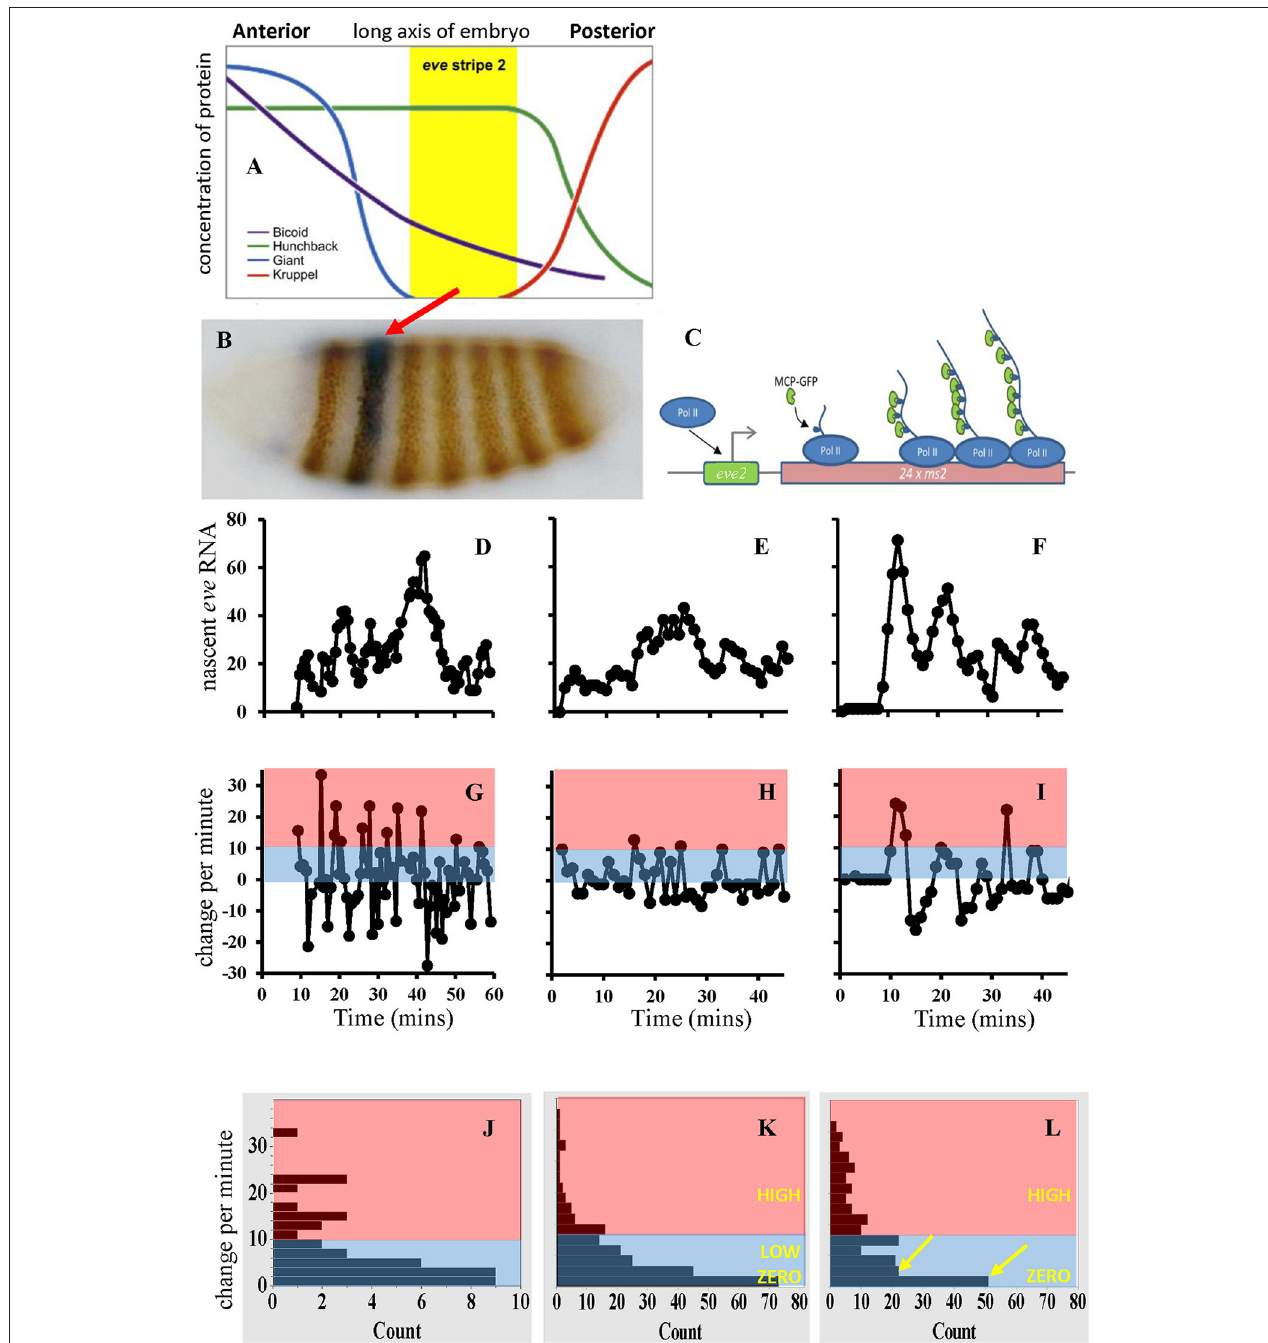
FIGURE 1 | (A) Spatial expression of several Drosophila segmentation genes. (B) eve gene expression stripes on an interphase 14 embryo. Red arrow, eve stripe 2. (C) Schematic of the MCP/MS2 system. “ eve2 ” represents the CRE controlling transcriptional initiation (right-angle arrow); see Figure 2A for an expanded view and model of this eve MSE. PolII transcribes multiple MS2 loops in addition to the target gene. MS2 loops in the nascent RNA bind MCP tagged with green fluorescent protein (GFP). (D) Experimental time series from a nucleus in the center of eve stripe 2, from Bothma et al. [54]. (E) A stochastic simulation for OFF-LOW-HIGH eve2 transcription (model in Figures 2A,B ). (F) A simulation of simple OFF-ON transcription. Experimental time series exhibit a 10min initial lag, simulation dynamics start at time 0; time axes same as (G–I) , vertical scale (number of transcript molecules) shared (D–F) . (G–I) Corresponding change per minute for the data (G) , and for the OFF-LOW-HIGH (H) , and OFF-ON (I) simulations. Pink, minutes with high initiation; blue, minutes with low to zero initiation. (J–L) Distributions of change-per-minute for data ( J , from G ), OFF-LOW-HIGH ( K , 10 pooled simulations) and OFF-ON ( L , also 10 simulations; yellow arrows indicate dichotomy in low to zero rates not seen in J,K ). Vertical bin ranges identical for (J–L) . LOW corresponds to k B 000 in Figure 2 , HIGH to k BH00 . (A,B) adapted from Levine [79], (C) from Desponds et al. [53], (D–L) from Holloway and Spirov [66].